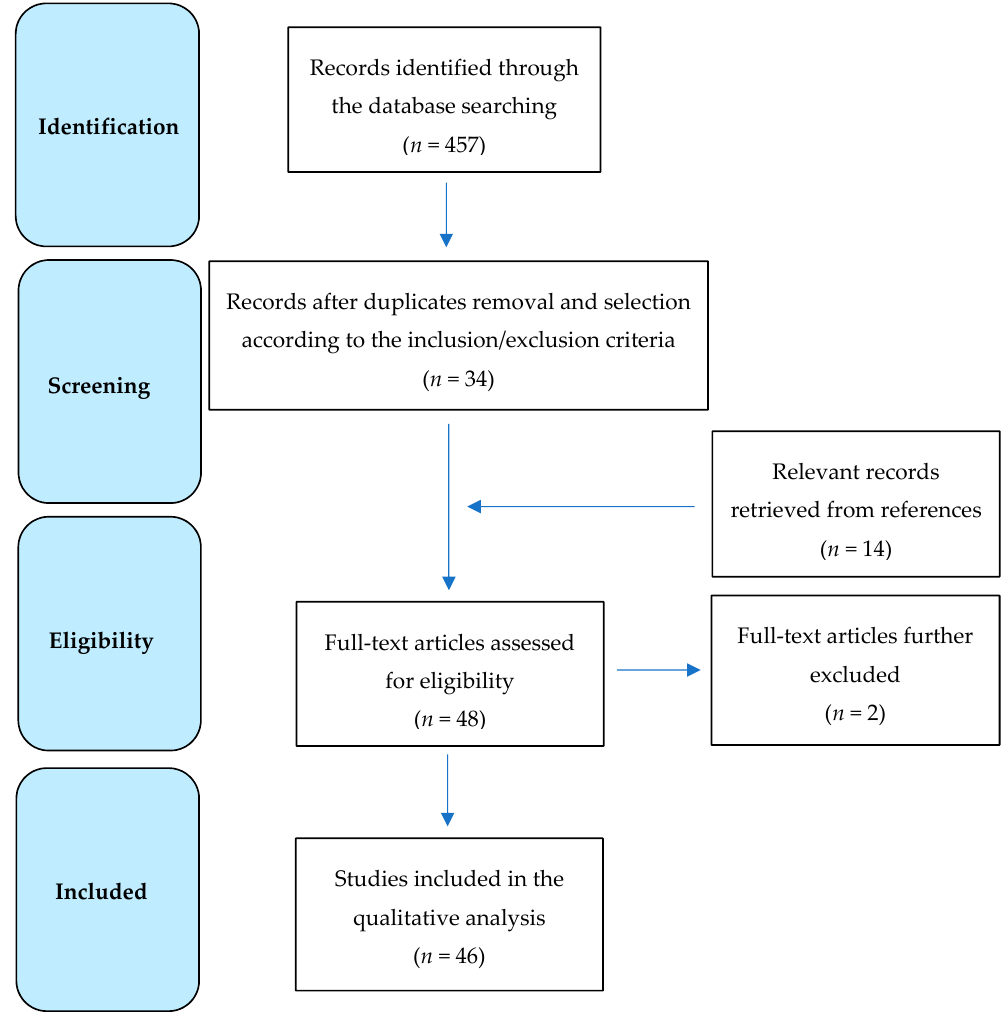
Figure 1. Flow diagram showing the search strategy, the number of records identified, and the number of included/excluded studies [55].